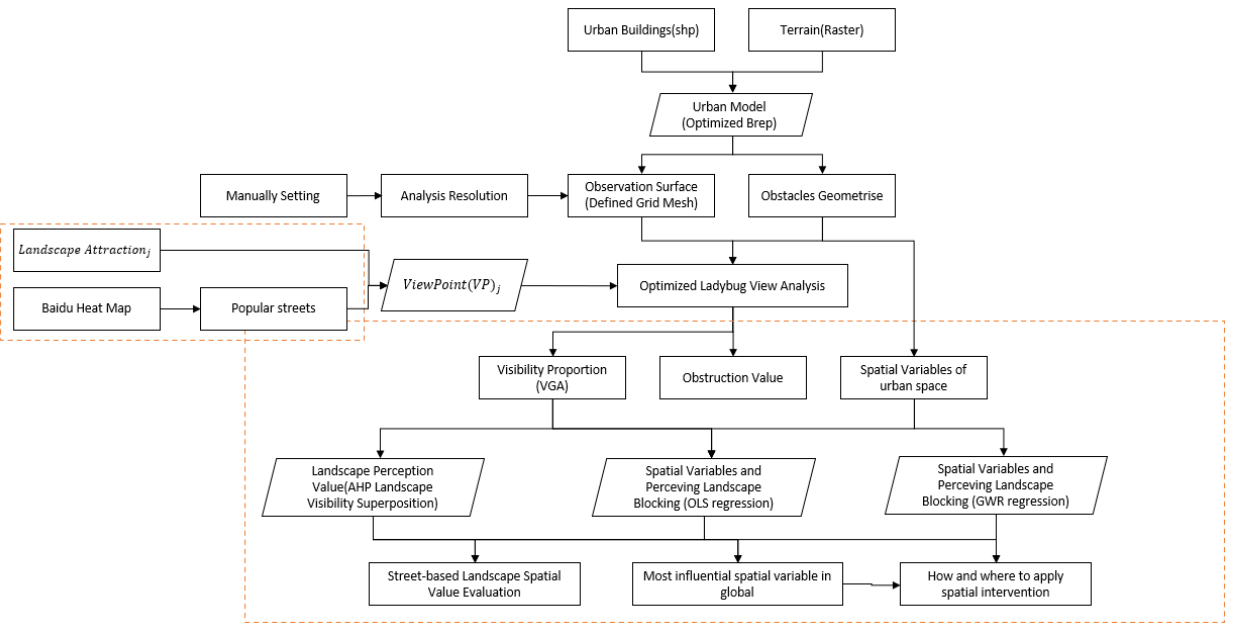
Figure 1. Conceptual framework of the new optimized spatial visual analysis route.